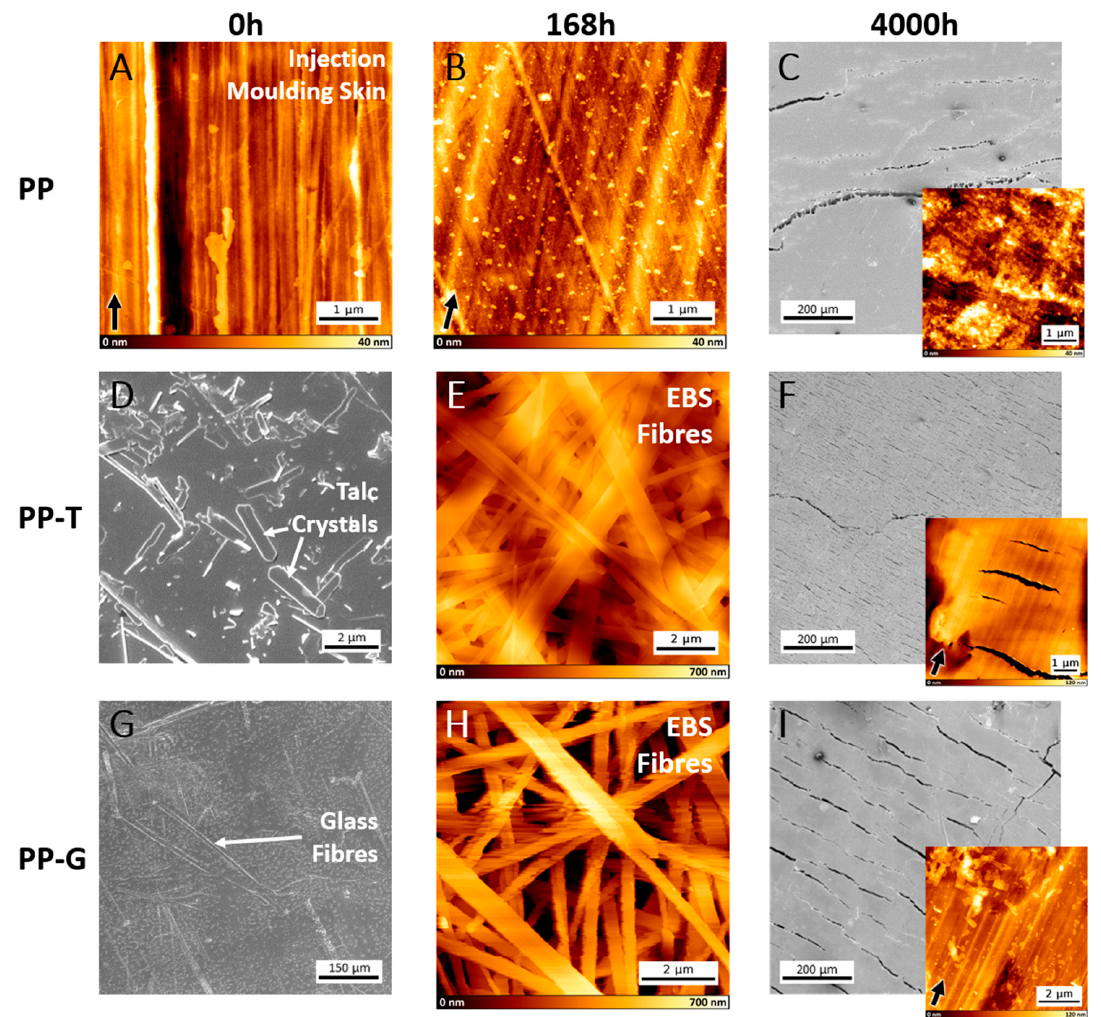
Figure 1. SEM images in grey and AFM images in gold-brown show the structural changes during aging of samples PP, PP-T, and PP-G. The first column ( A , D , G ) depicts the untreated state of the samples with the typical injection moulding surface and the filling material. Two samples show fibre-like EBS on the surface after 168 h in the detergent at 95° ( E , H ). After 4000 h the crack formation ( C , F , I ) as well as the difference in degradation of the skin layer ( C , F , I inlay) can be seen. Black arrows indicate the injection direction, white arrows the fillers.